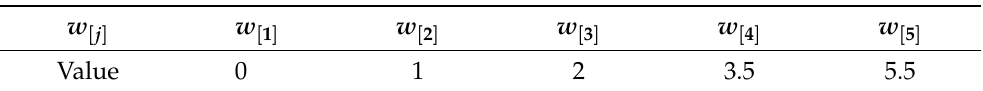
Table 4. Waiting